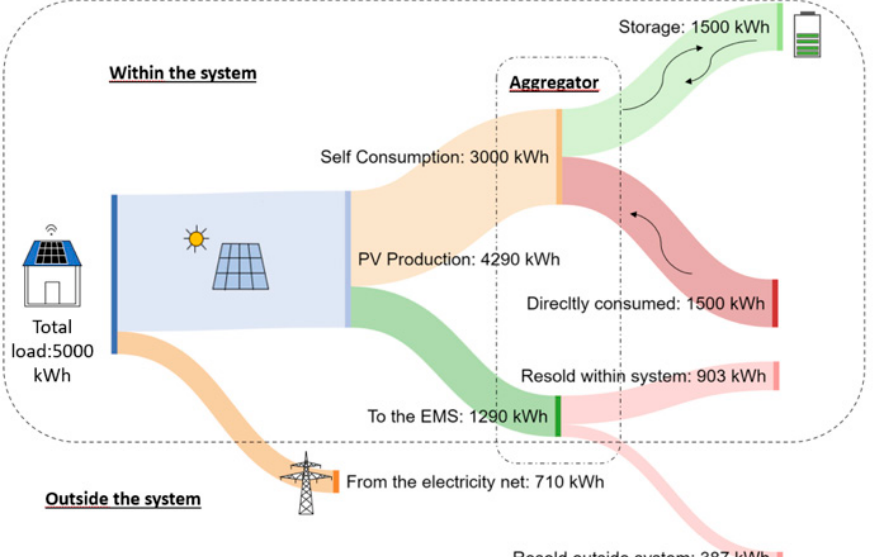
Figure 5. Case study baseline